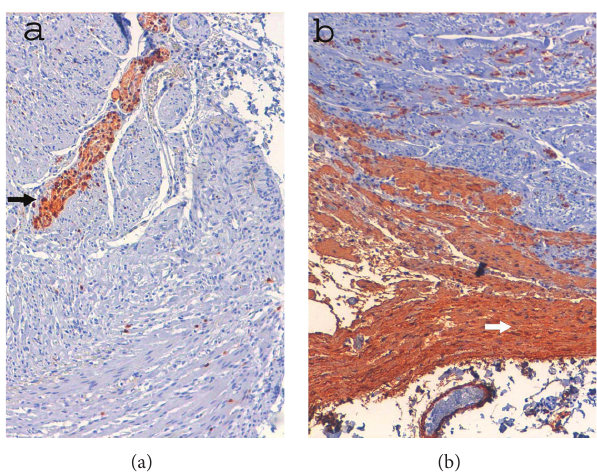
Figure 5: Immunohistochemical features of GIST: (a) S-100 negativity. Instead overexpressed in nerve cells (black arrow) —10x (b) SMA (smooth muscle actin) negativity. Instead overexpressed in muscular gastric wall cells (white arrow)